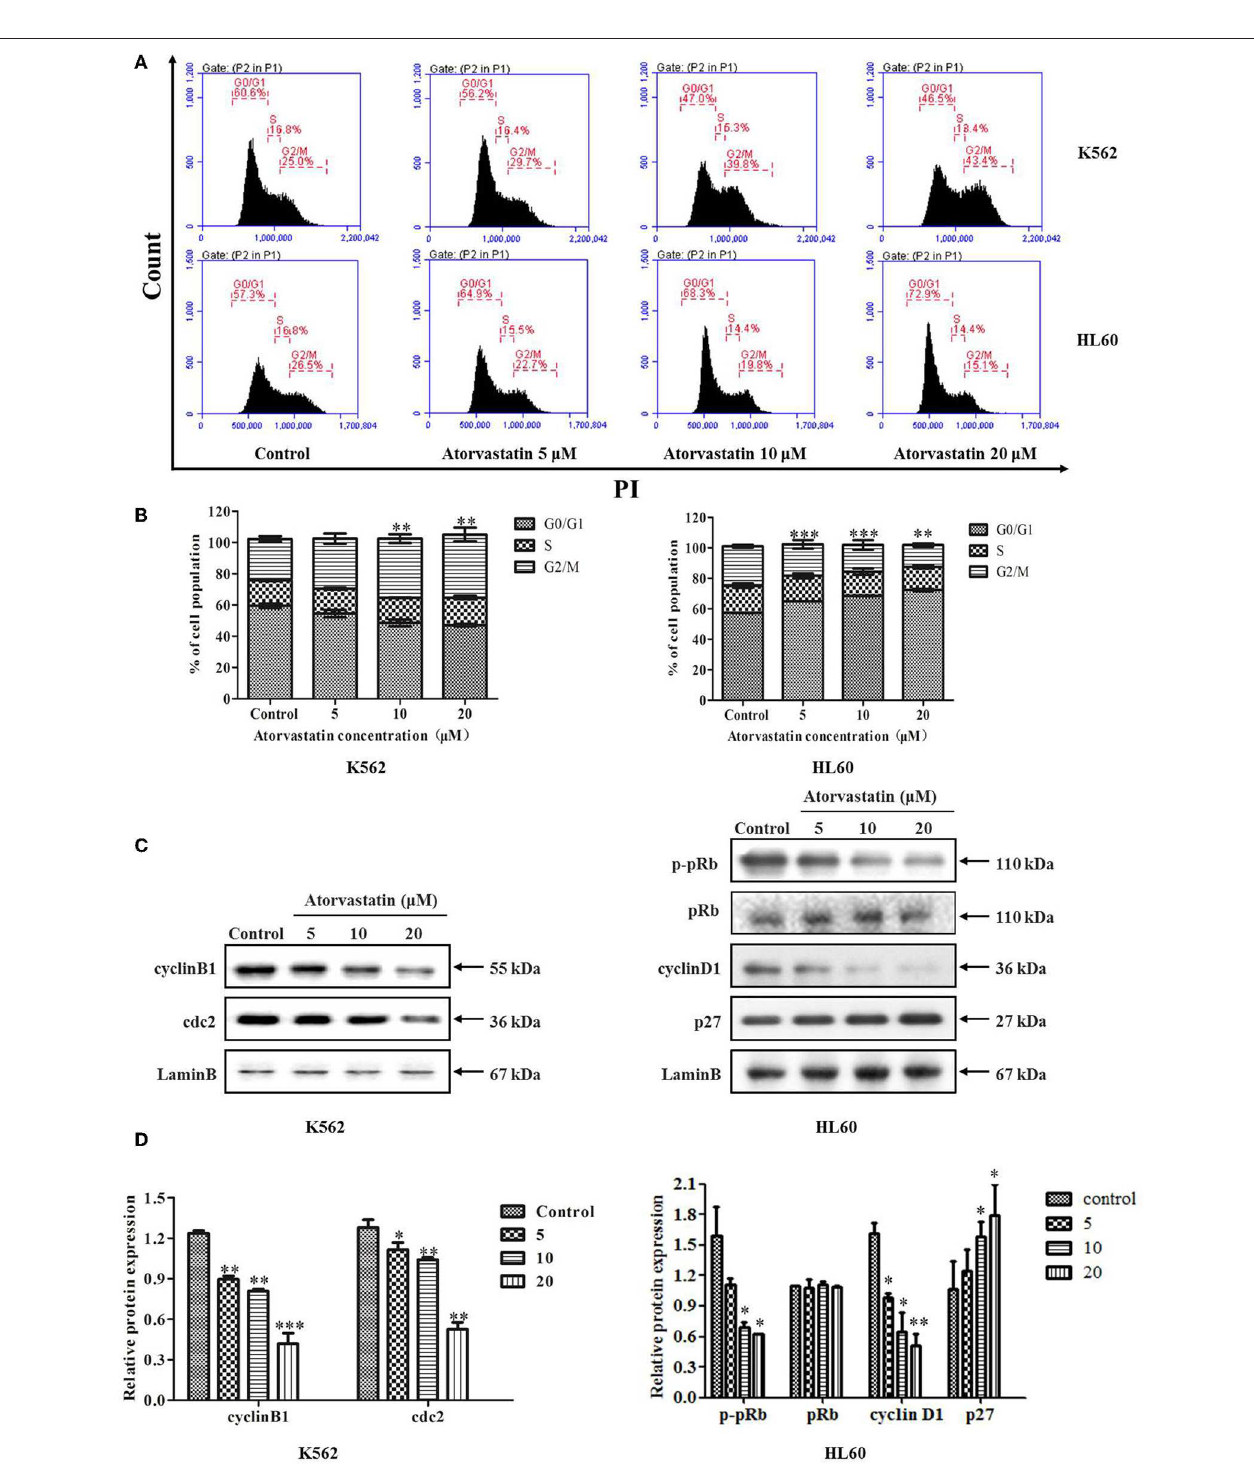
FIGURE 2 | Atorvastatin induces cell cycle arrest in K562 and HL60 cells. K562 and HL60 cells were incubated with Atorvastatin (0, 5, 10, and 20 µ M) for 48h. (A) Cell cycle distribution was analyzed by flow cytometer, and the representative images were shown. (B) The percentages of total cells at G0/G1, S, and G2/M phases in K562 and HL60 cells were shown and statistically analyzed. (C) The levels of cyclinB1 and cdc2 in K562 cells, as well as cyclinD1, p27, p-pRb, and pRb in HL60 cells were determined by western blot. (D) Bar graphs show the relative levels of cyclinB1, cdc2, cyclinD1, p27, p-pRb, and pRb. Data are presented as mean ± SD of three independent experiments. * p < 0.05, ** p < 0.01, *** p < 0.001 vs. control.